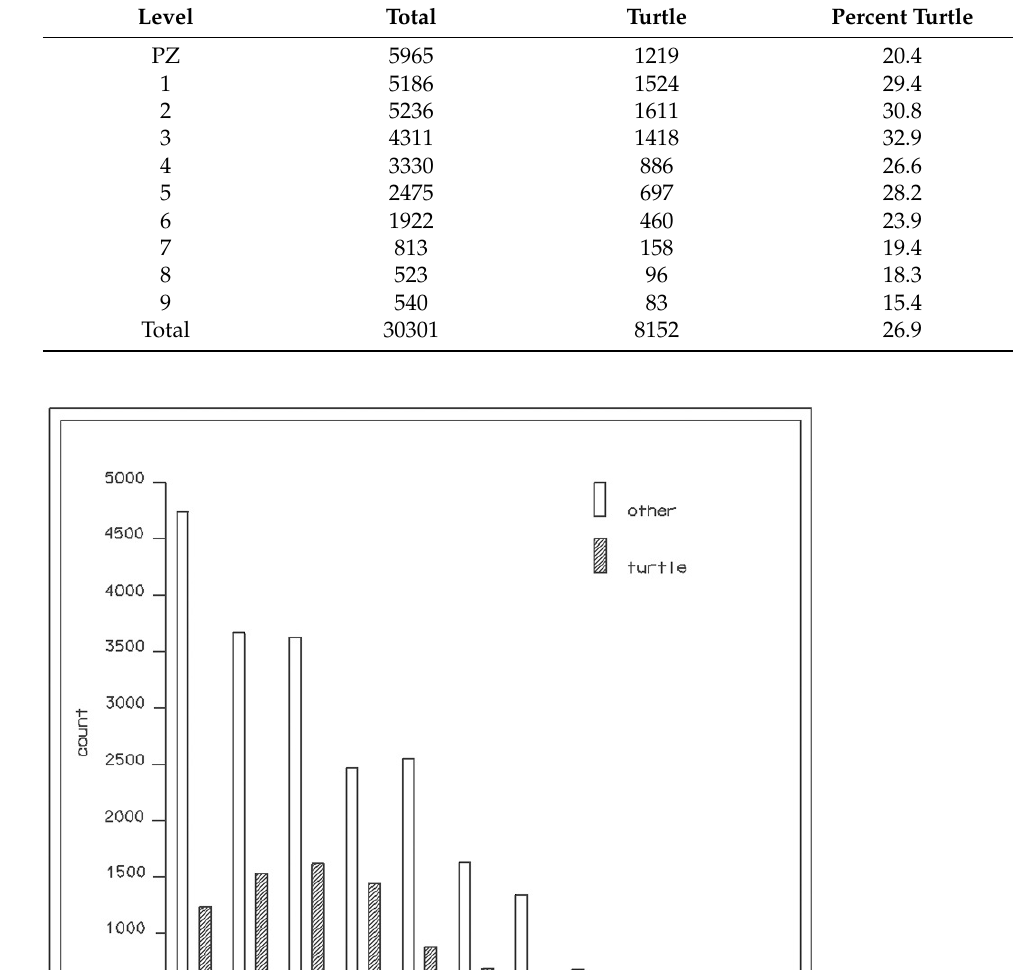
Table 2. Total bone fragments and turtle by level.